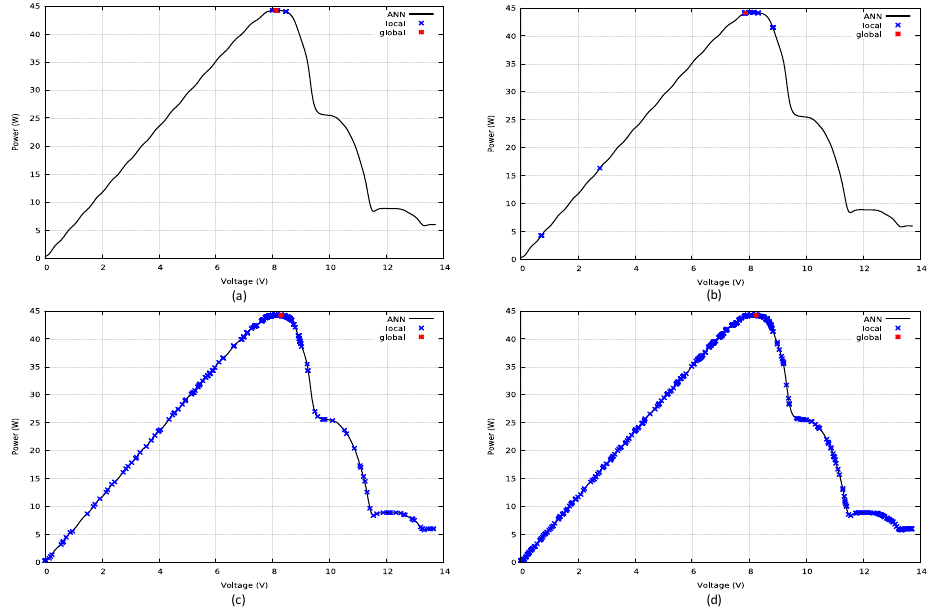
Figure 9. Results obtained with the algorithms for the test function 3: ( a ) GSS; ( b ) SA (T = 0.5); ( c ) SA (T = 100); ( d ) SA (T = 1000).